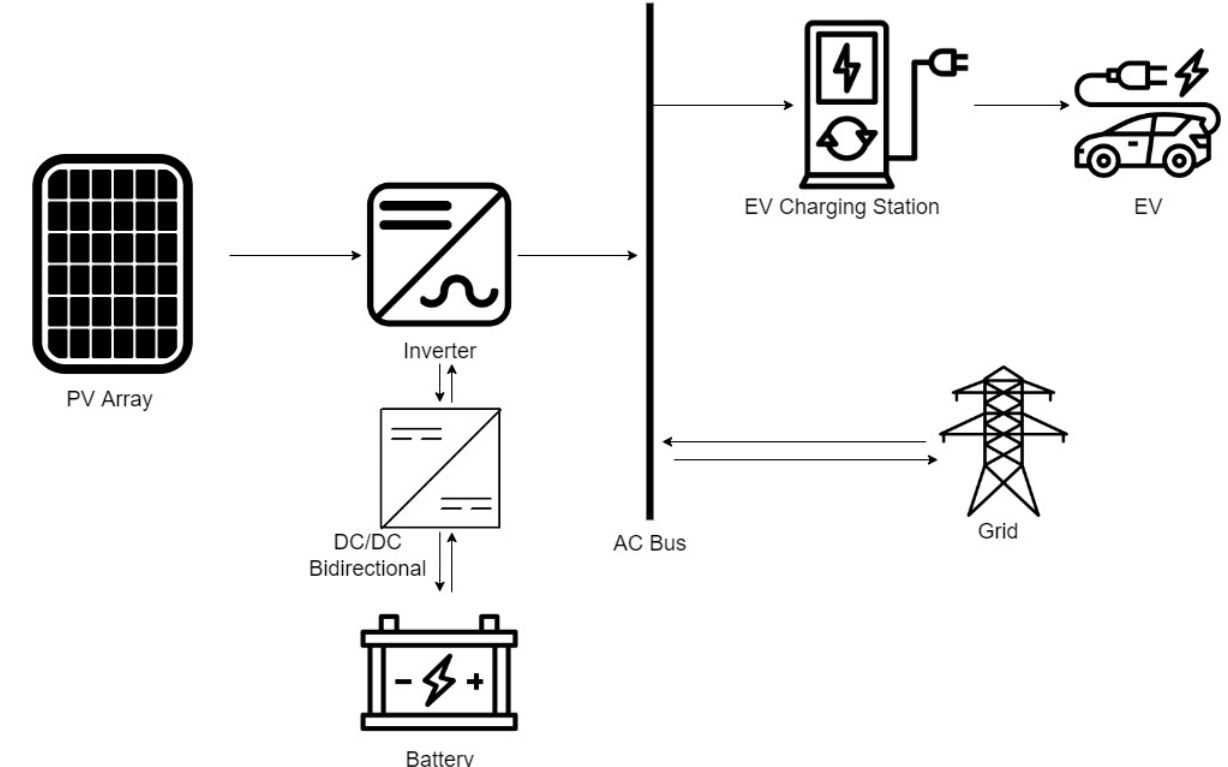
Figure 4. PV − grid battery system .